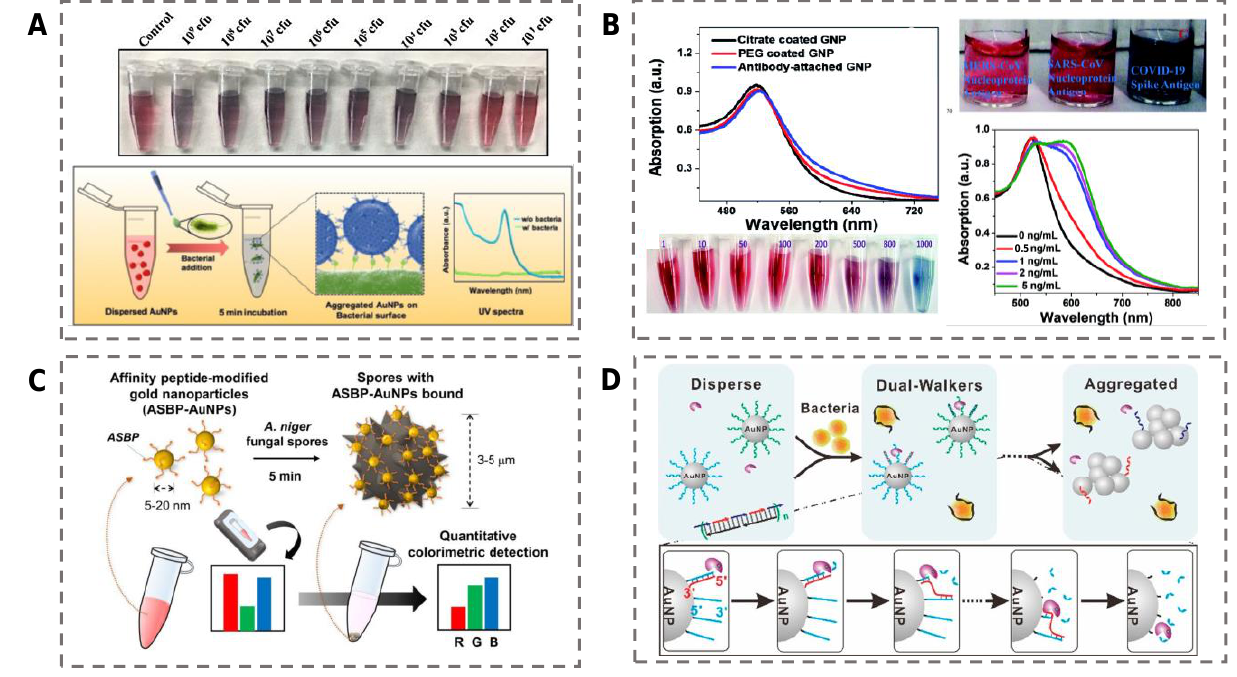
Figure 2. Colorimetric detection of pathogens based on antibody-, peptide-, and aptamer-functionalized AuNPs. ( A ) A colorimetric sensor with antibody-conjugated PEG-GO – AuNPs for E. coli and S. typhimurium detection. Reproduced with permission [51]. Copyright 2021, Elsevier. ( B ) A colorimetric sensor with antibody-attached AuNPs for rapid SARS-CoV-2 virus detection. Reproduced with permission [52]. Copyright 2021, Royal Society of Chemistry. ( C ) A colorimetric sensor with peptide-attached AuNPs for allergenic fungal spore detection. Reproduced with permission [56]. Copyright 2021, Elsevier. ( D ) A colorimetric sensor with aptamer-modified AuNPs for MRSA detection. Reproduced with permission [64]. Copyright 2020, American Chemical Society.